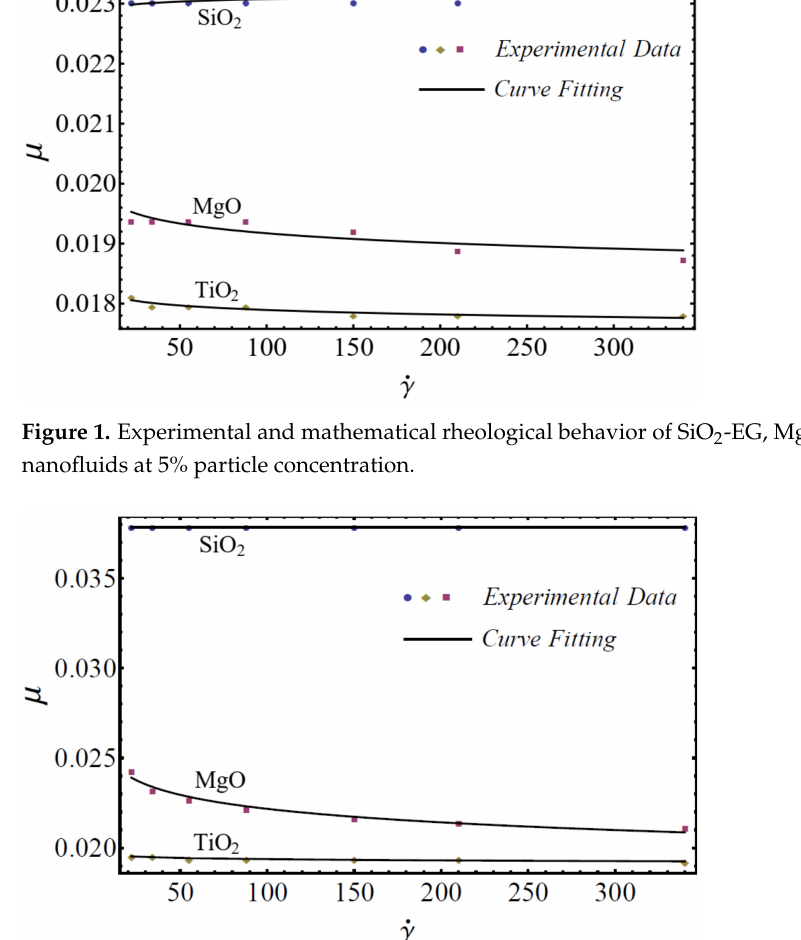
Figure 2. Experimental and mathematical rheological behavior of SiO 2 -EG, MgO-EG, and TiO 2 -EG nanofluids at 10% particle concentration.